Question: In one sentence, what is this figure communicating?
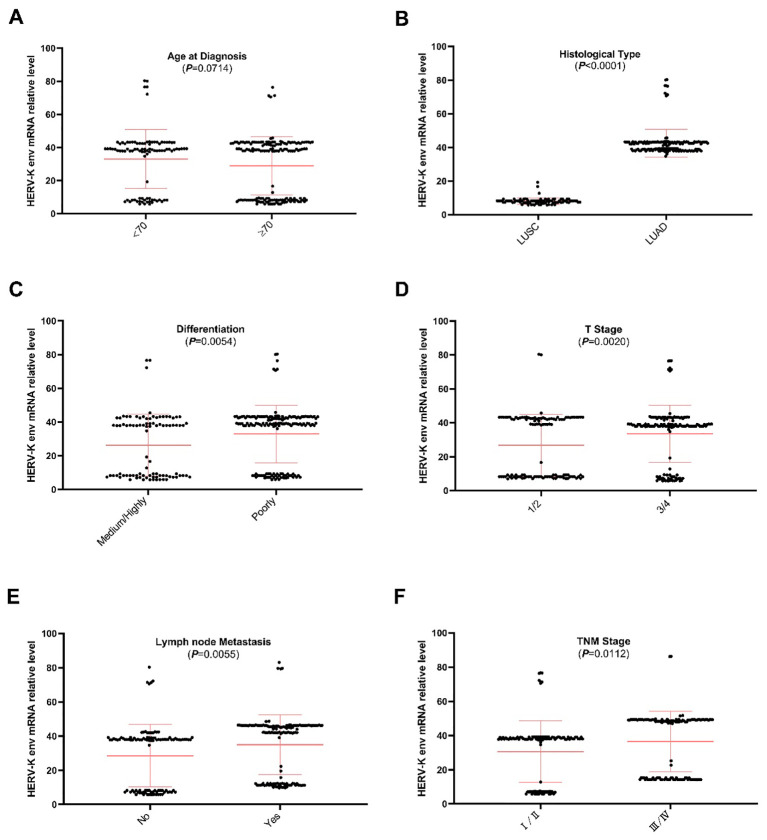
Answer: Analysis of the correlation between plasma HERV-K env mRNA expression levels and clinicopathological features in lung cancer patients. (A) Association between age at diagnosis and plasma HERV-K env mRNA levels. (B) Comparison of plasma HERV-K env mRNA expression levels across different histological subtypes. (C) Comparison of plasma HERV-K env mRNA expression levels stratified by tumor differentiation grade. (D) Comparison of plasma HERV-K env mRNA expression levels according to T stage classification. (E) Association between lymph node metastasis status and plasma HERV-K env mRNA levels. (F) Comparison of plasma HERV-K env mRNA expression levels across TNM stages. Data are presented as mean ± SEM. Statistical analyses were performed using unpaired Student’s t-test for comparisons between two groups. A P -value less than 0.05 was considered statistically significant.